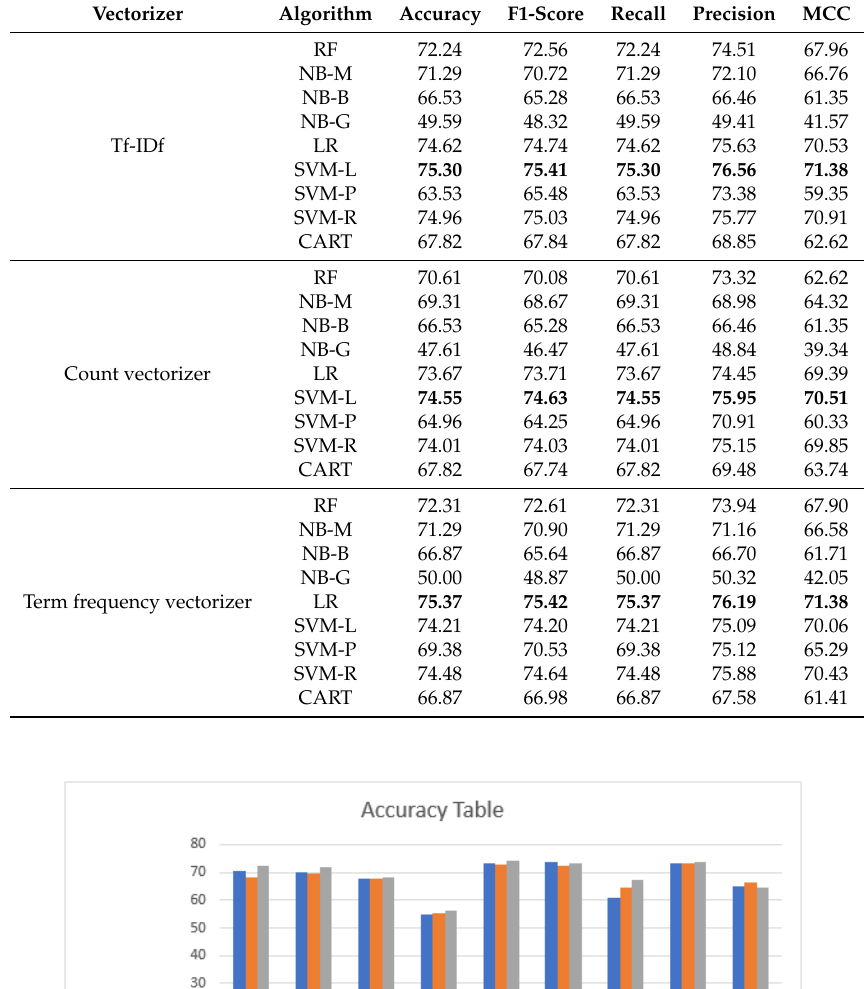
Table 7. Validation results on Kabita’s Kitchen dataset.